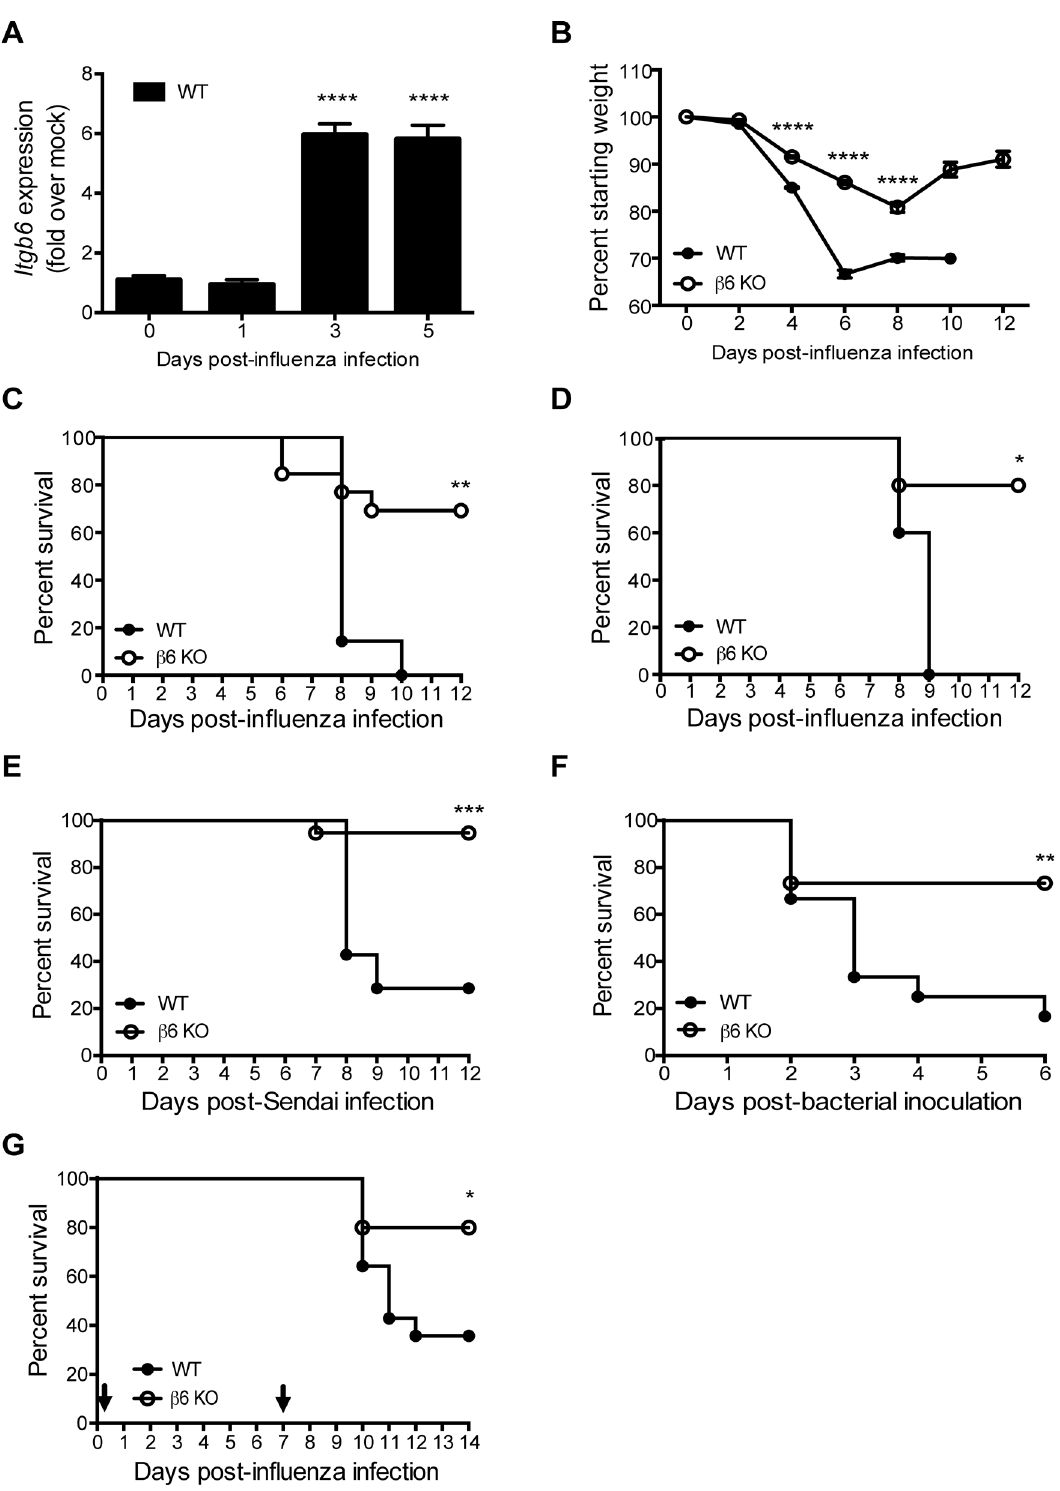
Fig 1. Inhibiting increased β 6 integrin levels during respiratory infections is protective. β 6 KO or WT mice were intranasally inoculated with CA/09 H1N1 influenza virus (10 4 TCID 50 ) and monitored for (A) β 6 mRNA expression in lungs as quantitated by qPCR and normalized to GAPDH as a control. Data is pooled from 2 independent experiments with n = 2 mice per group. p < 0.0001 by Student ’ s t test; (B) weight loss and (C) survival for 12 dpi. Data from (B) is pooled from 6